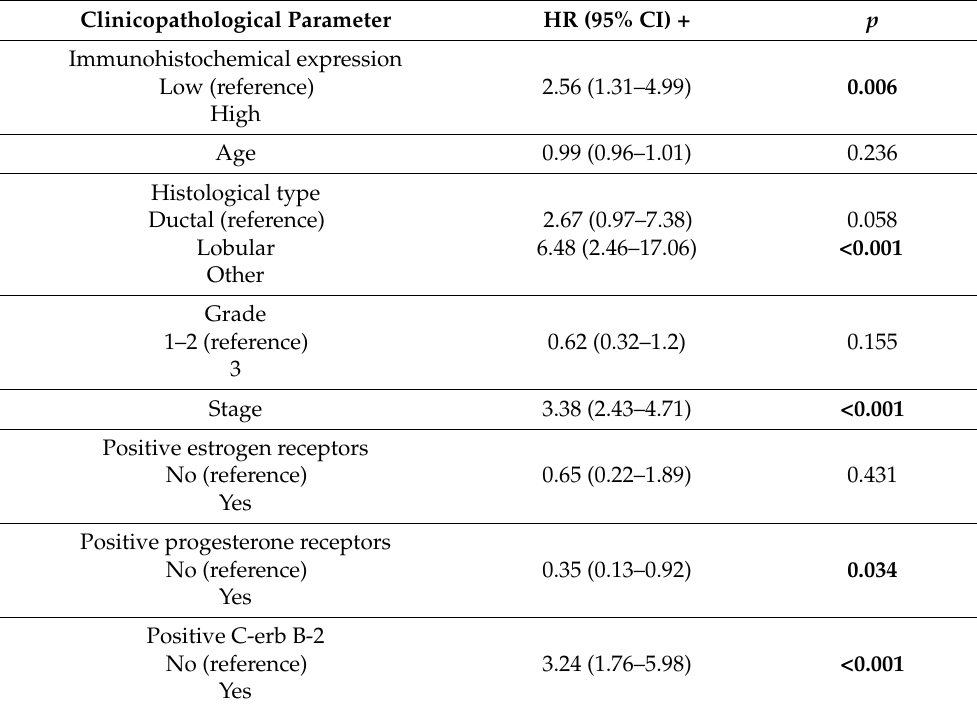
Table 4. Multiple Cox regression analysis results for overall